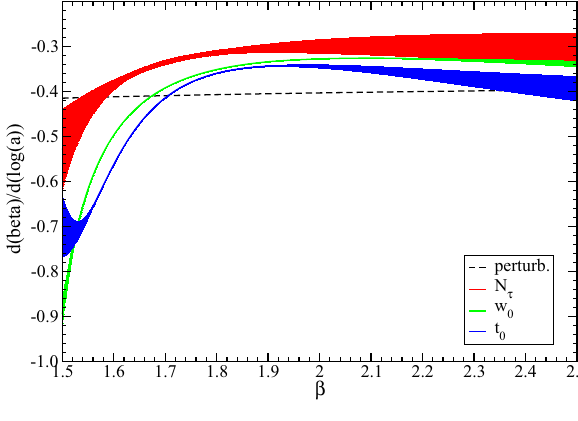
Fig. 3 Interpolation of w 0 versus β using “Fit2” and “Fit6” of Table 4